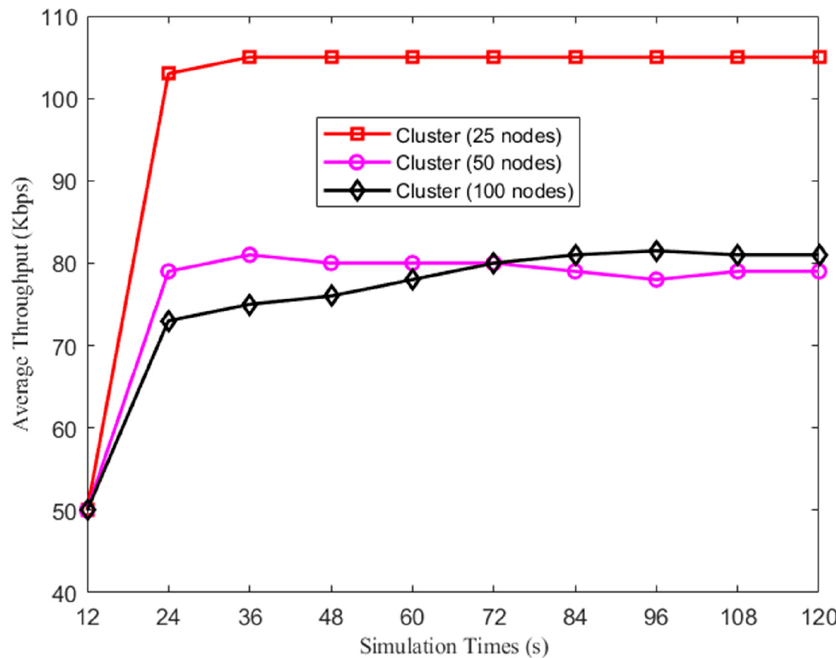
Figure 8. Average throughput comparison among 25, 50, and 100 nodes.